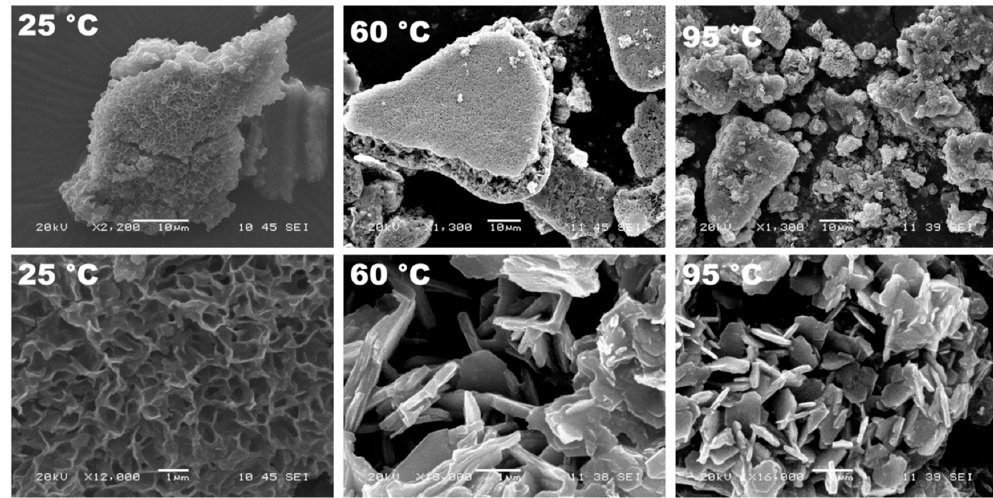
ff erent 2 at di